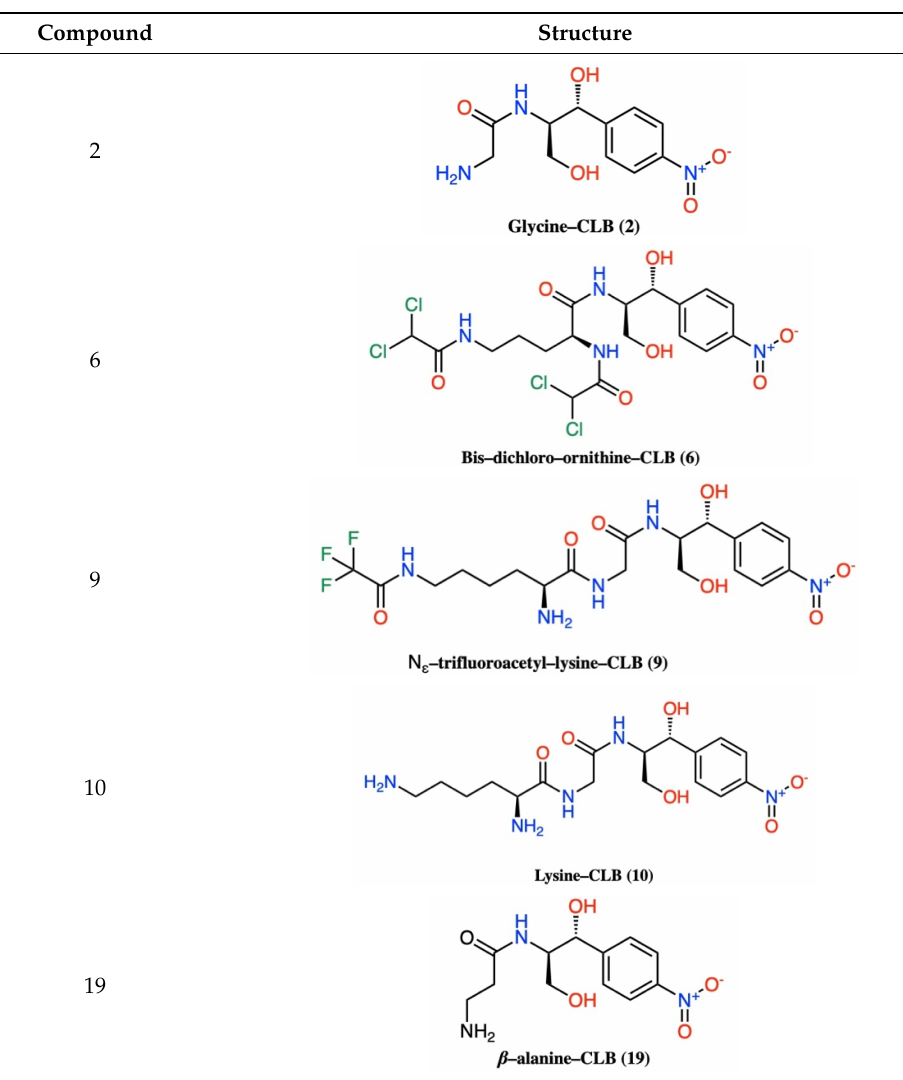
Table 2. Chemical structure for the most active compounds of Figure